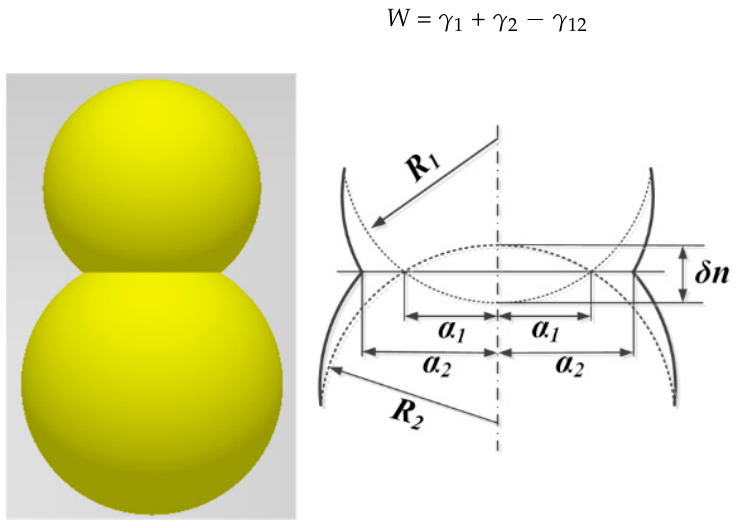
Figure 1. The JKR bonding model.